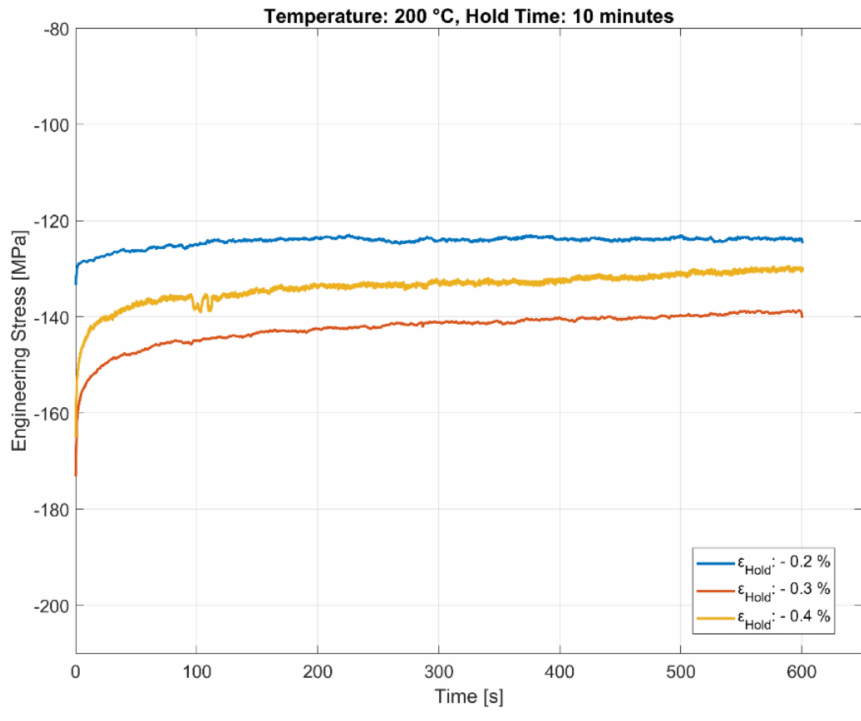
Figure 8. E ff ect of strain amplitude on stress relaxation at 200 ◦ C.